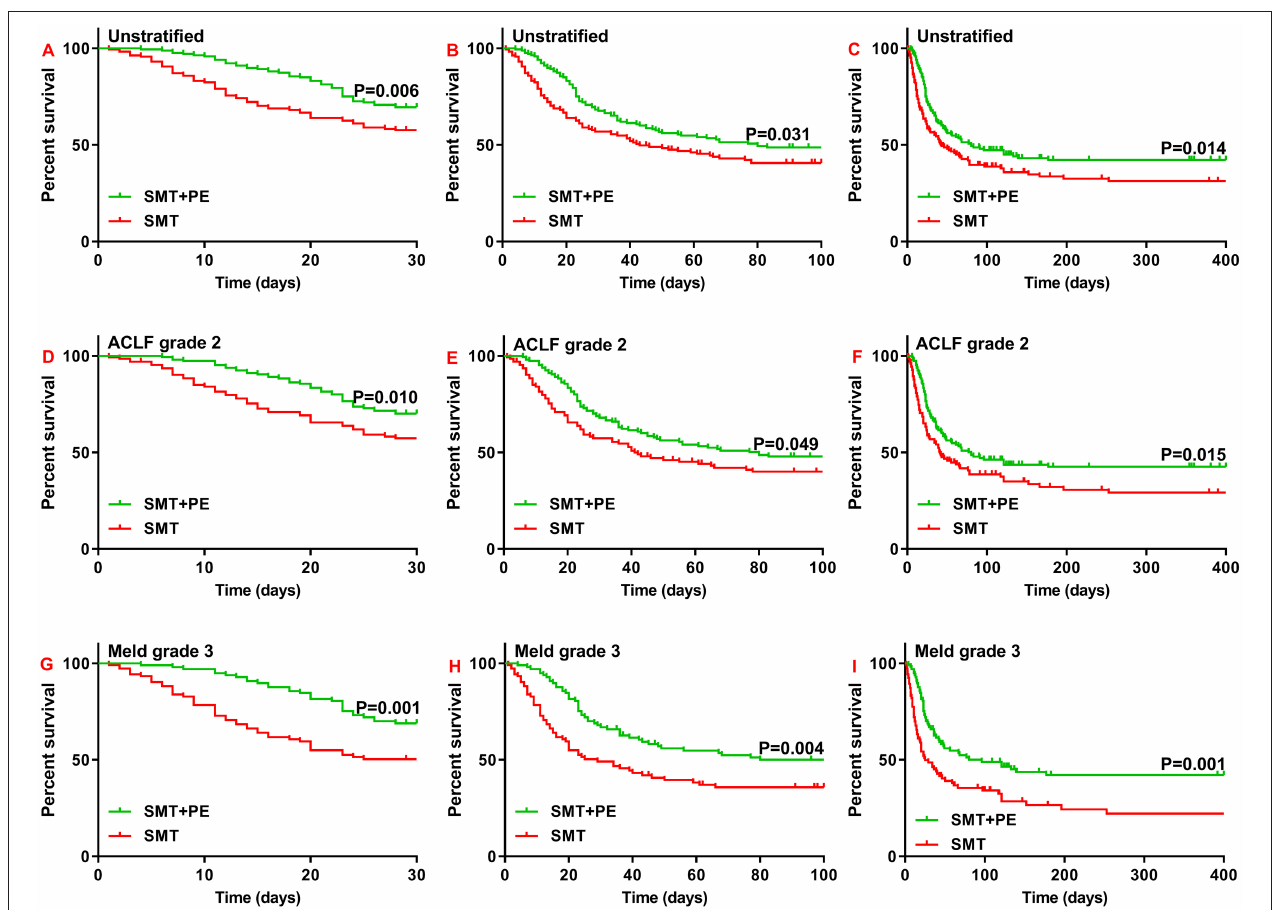
FIGURE 3 | Survival curves for 166 pairs of matched patients with HBV-ACLF who received SMT alone or SMT + PE. (A–C) 28-day (A) , 90-day (B) , and 1-year (C) survival curves for patients with HBV-ACLF. (D–F) 28-day (D) , 90-day (E) , and 1-year (F) survival curves for HBV-ACLF patients with ACLF grade 2. (G–I) 28-day (G) , 90-day (H) , and 1-year (I) survival curves for HBV-ACLF patients with MELD scores of 30 to 40. PE, plasma exchange; SMT, standard medical therapy; HBV-ACLF, hepatitis B virus-associated acute-on-chronic liver